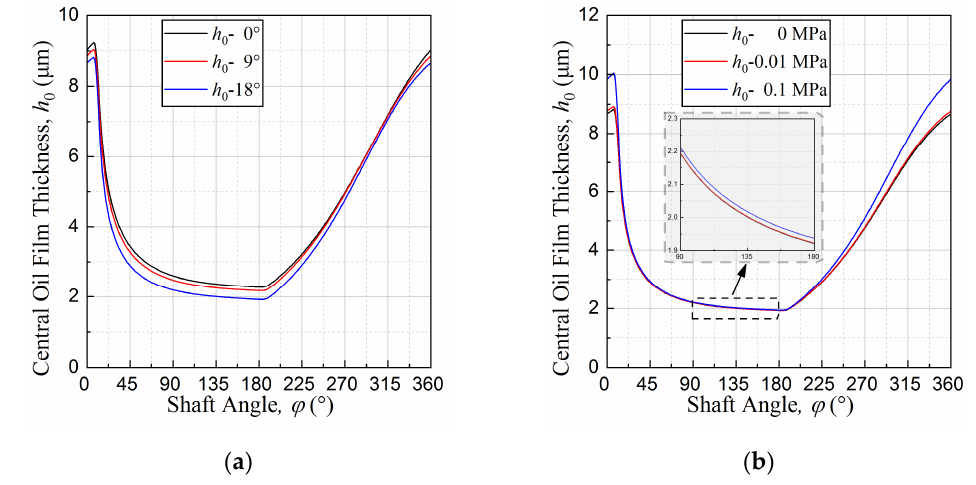
Figure 12. Central oil film thickness under different swashplate inclination angle and pump house pressure, where ( a ) is under different swashplate inclination angle; ( b ) is under different pump house pressure.